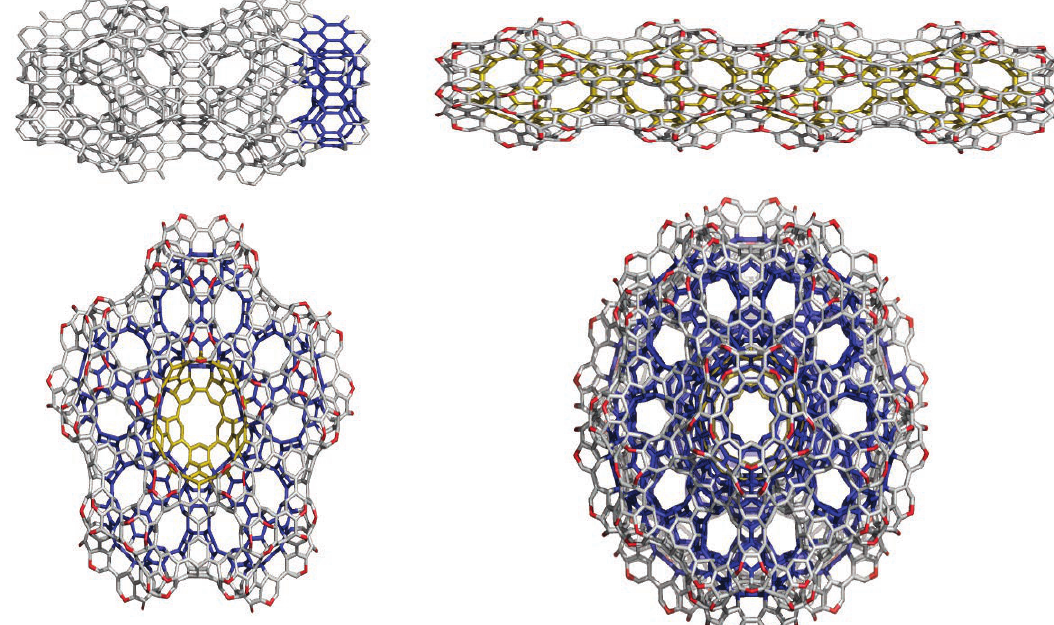
Figure 5. Top row: the repeating unit BTA20_2_1350 (left) and a rod-like BTZ20_4_1560 (right). Bottom row: multi tori BTZCy20_5_1800 (left) and BTZSp20_12_3120 (five-fold